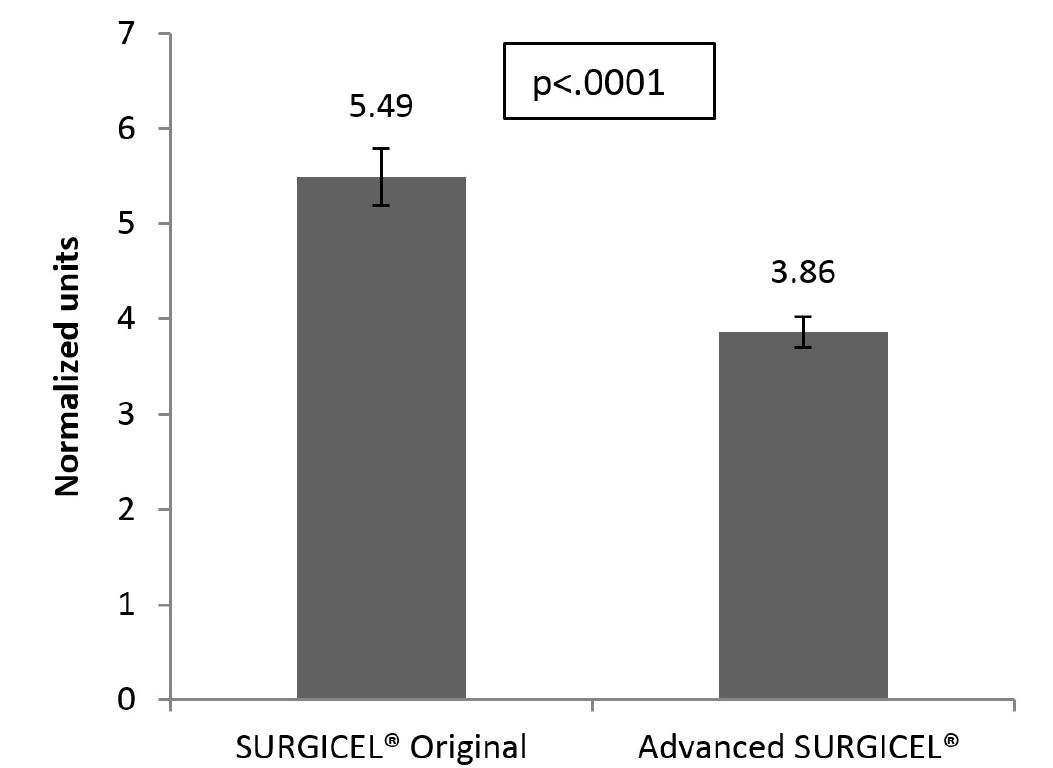
Figure 2. Unadjusted analysis of normalized units of SURGICEL® used per surgery1,